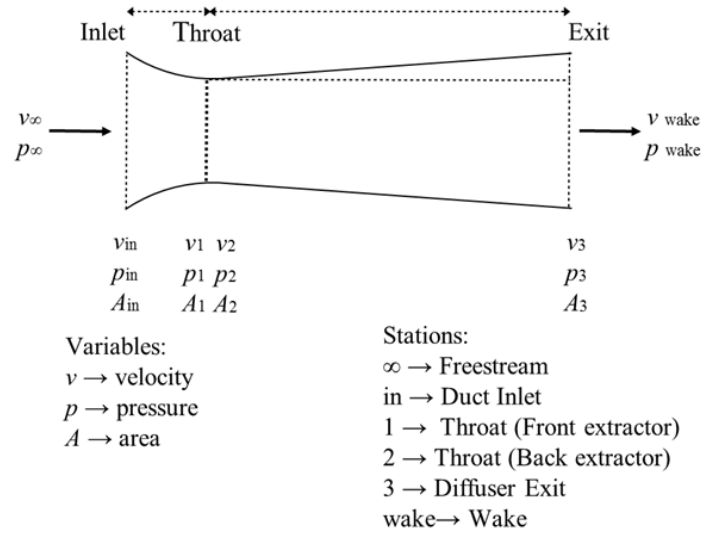
Figure 1. Schematic of a ducted